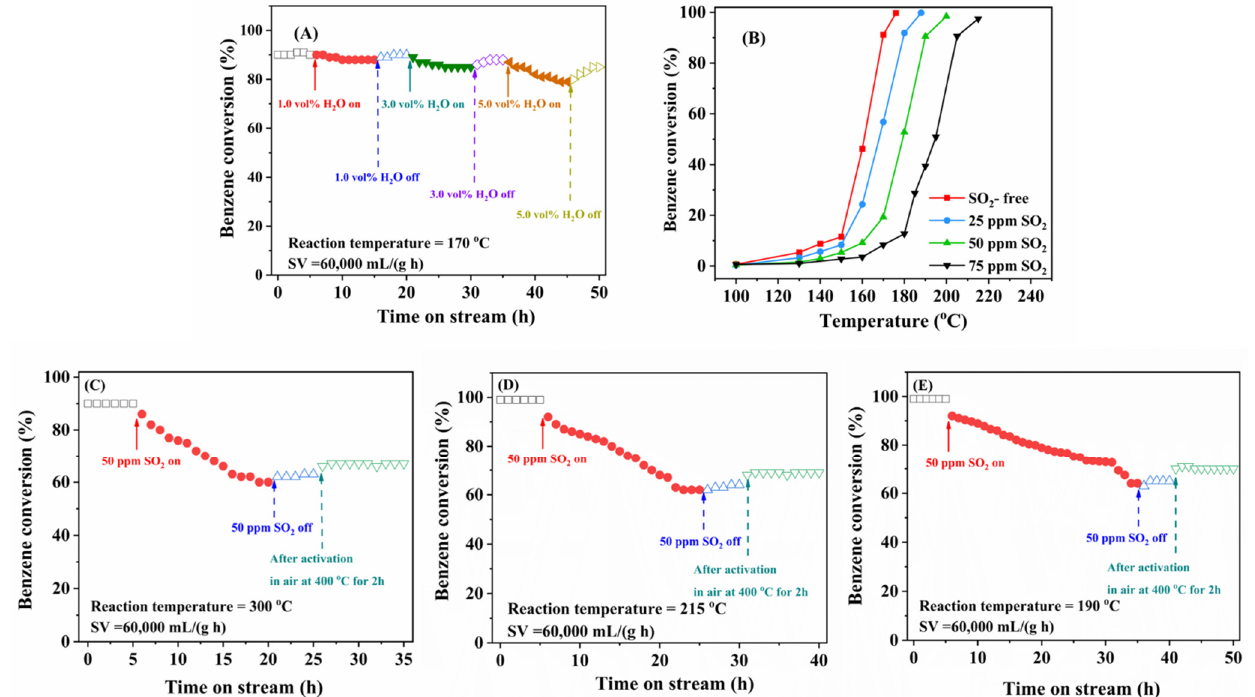
Figure 7. ( A ) Effect of water vapor on the conversion of benzene over the 0.94Pt-1.0rGO/ α -MnO 2 sample at 170 °C and SV = 60,000 mL/(g h), ( B ) effect of SO 2 on catalytic activity of the 0.94Pt- 1.0rGO/ α -MnO 2 sample for benzene oxidation at SV = 60,000 mL/(g h), and effect of 75 ppm SO 2 on benzene conversion over ( C ) α -MnO 2 , ( D ) 0.93Pt/ α -MnO 2 , and ( E ) 0.94Pt-1.0rGO/ α -MnO 2 at benzene concentration = 1000 ppm and different temperatures.